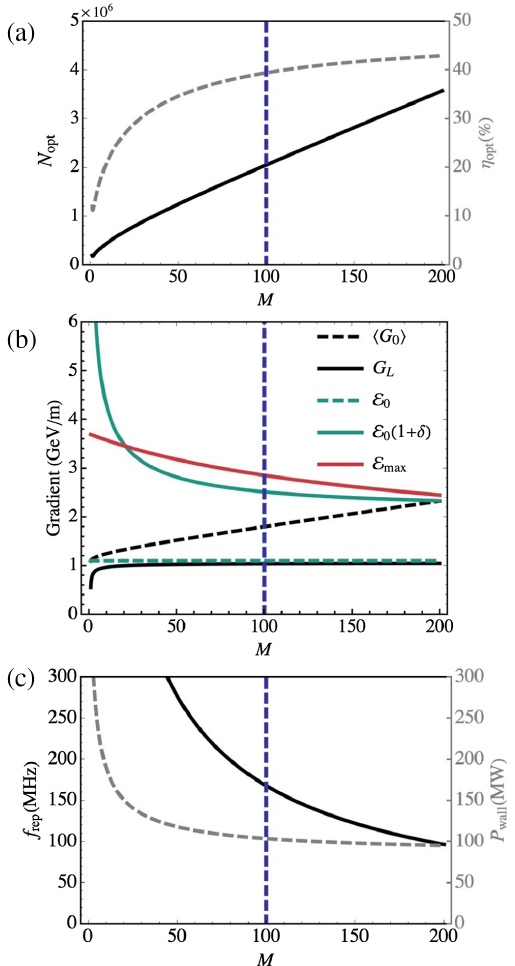
FIG. 1. Constrained parameters from Eq. (9) as function of number M of bunches, showing (a) macrobunch population (black) and optimal efficiency (gray); (b) corresponding field intensity parameters; and (c) corresponding laser repetition rate (black) and wallplug power (gray). All points on the curves are ¯ L ¼ 2 × 10 34 cm − 2 s − 1 . Vertical blue dashed lines matched to ref mark the value M ¼ 100 corresponding to the parameters